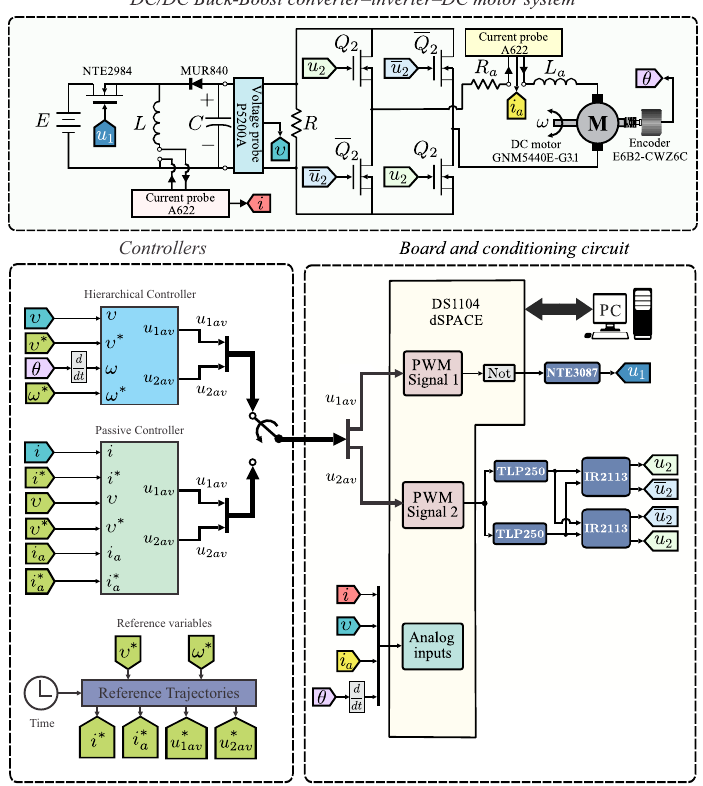
Figure 2. Connections diagram of the system in